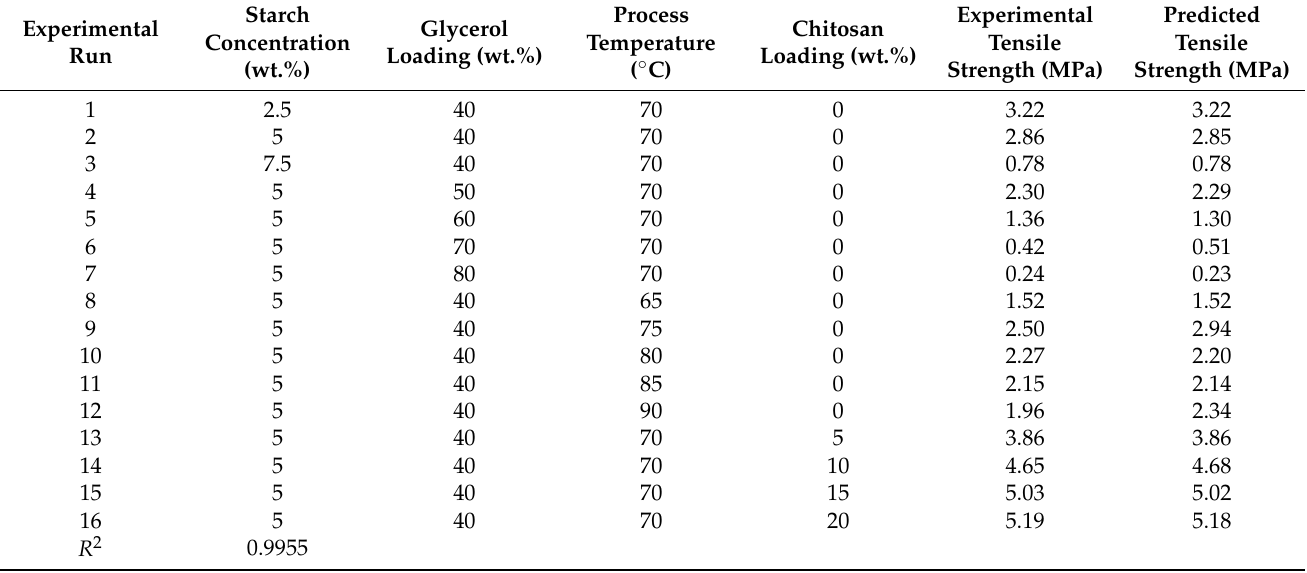
Figure 7. Architecture of ANN model for elongation at break.